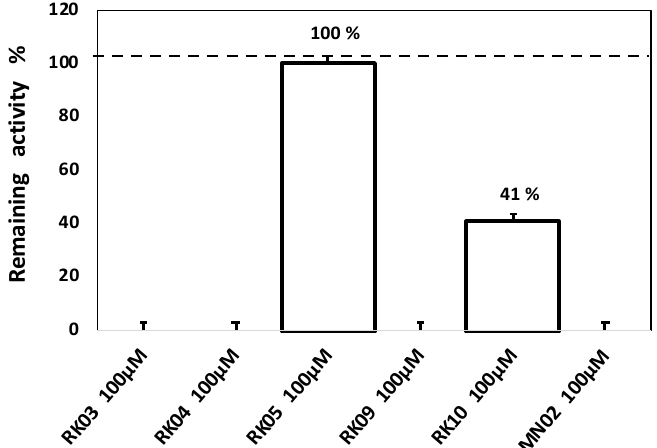
Figure 3. Inhibition activity of the tested compounds shown as remaining activity expressed in percentage of RK03, RK04, RK05, RK09, RK10 and MN02 as control.